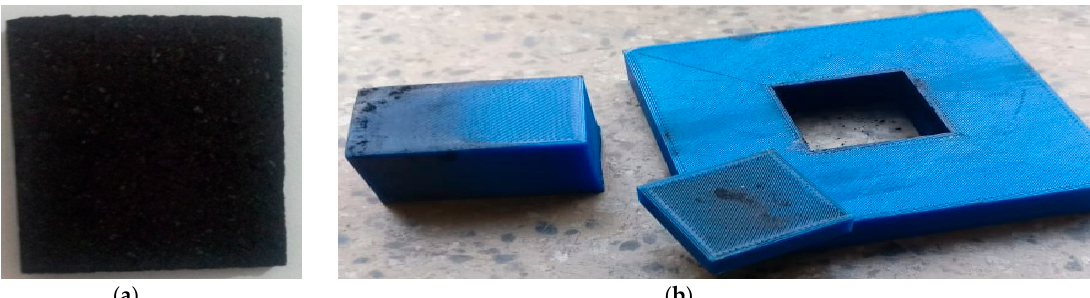
Figure 3. ( a ) Prepared multi-walled carbon nanotube electrode; ( b ) 3D mold used for fabrication of electrode.